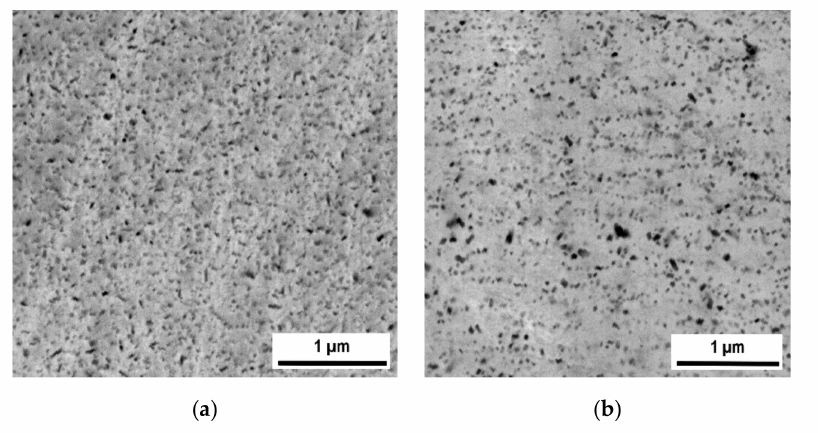
Figure 6. Comparison of microstructures of nano-oxide dispersion within grains of ( a ) Specimens I ( b ) Specimens II (SEM—backscattered